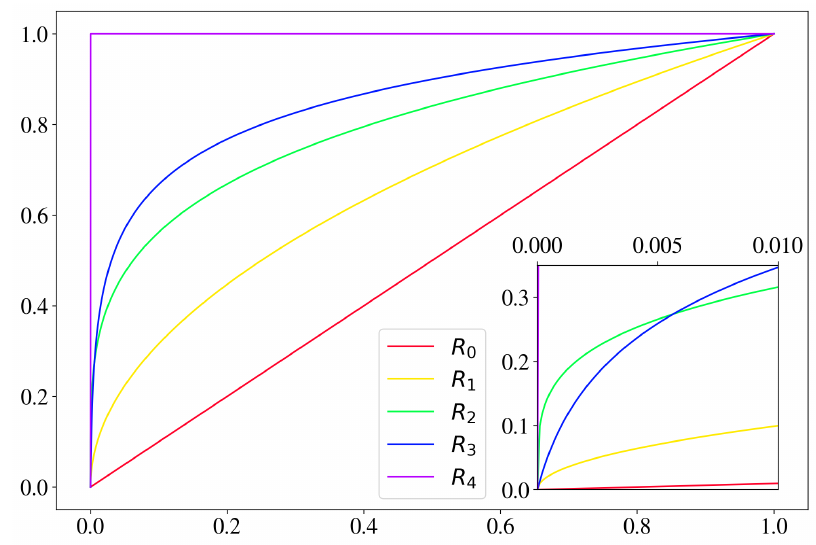
Figure 17 . Remapping functions for highlighting dim pixels, see eq.